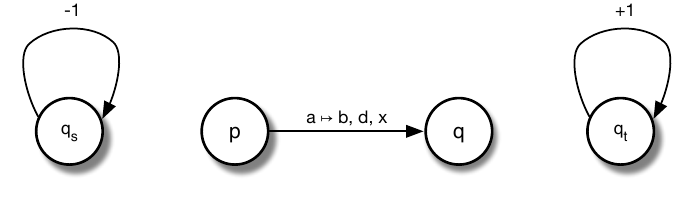
Figure 1. Transitions of a